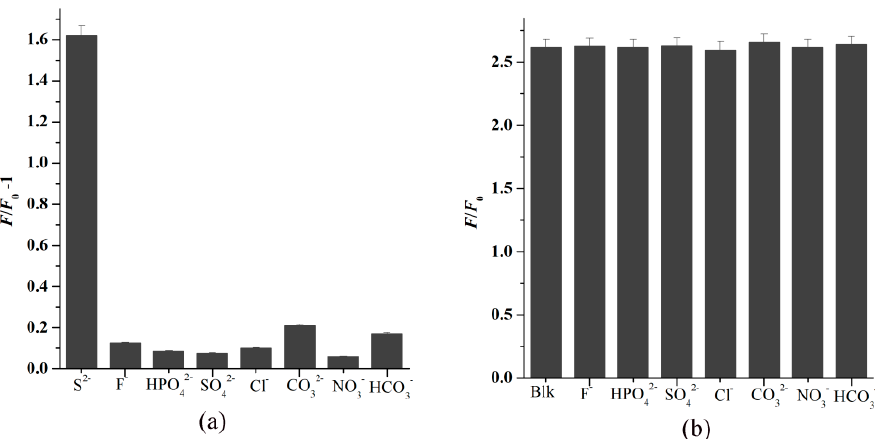
Figure 8. ( a ) FL response of FCD–Cu 2+ upon addition of various anions (15 µ M). ( b ) The effect of various coexisting anions (15 µ M) on selective sensing of S 2 − by FCD–Cu 2+ system (Blk is 20 µ M Cu 2+ and 15 µ M S 2 − , λ ex = 320 nm, λ em = 452 nm).